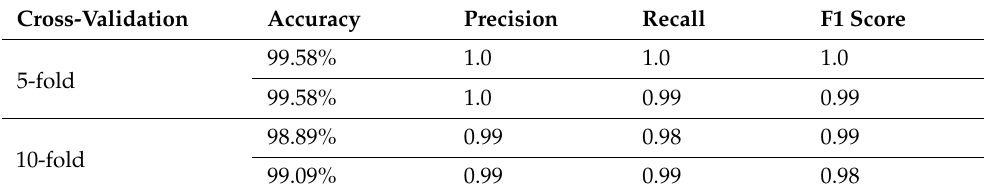
Table 2. Classification results of cotton disease.